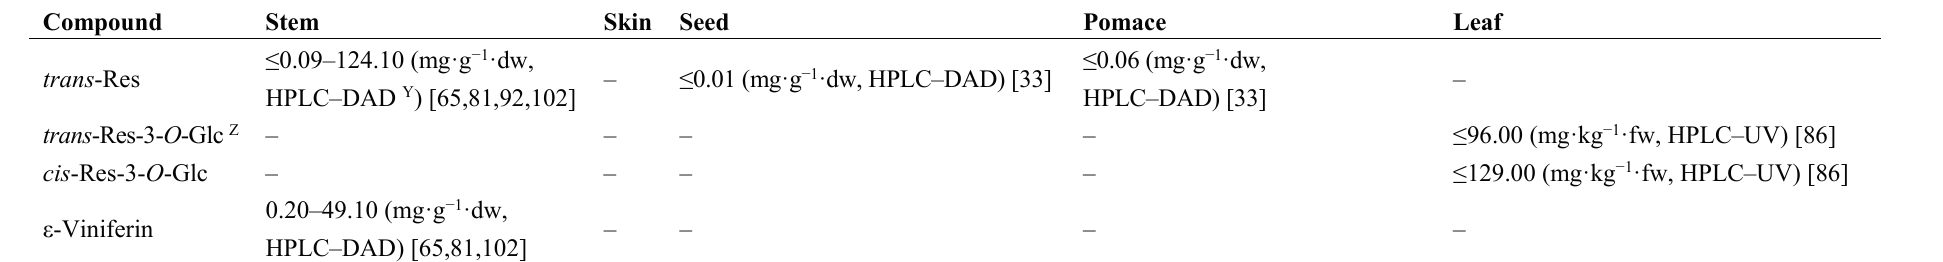
Table 6. Content in stilbenes (analytical technique employed) in winery residues of red grapes ( Vitis vinifera L.). Compound Stem Skin Seed Pomace Leaf trans -Res